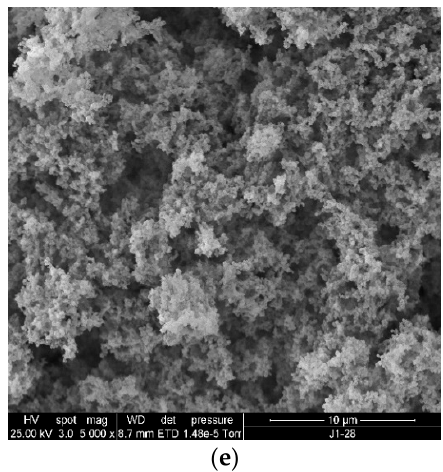
Figure 3. SEM images of plain ADG 0% ( a ), ADG with 15% black tea infusion ( b ), ADG with 30% black tea infusion ( c ), ADG with 45% black tea infusion ( d ), ADG with 60% black tea infusion ( e ) (day 28).